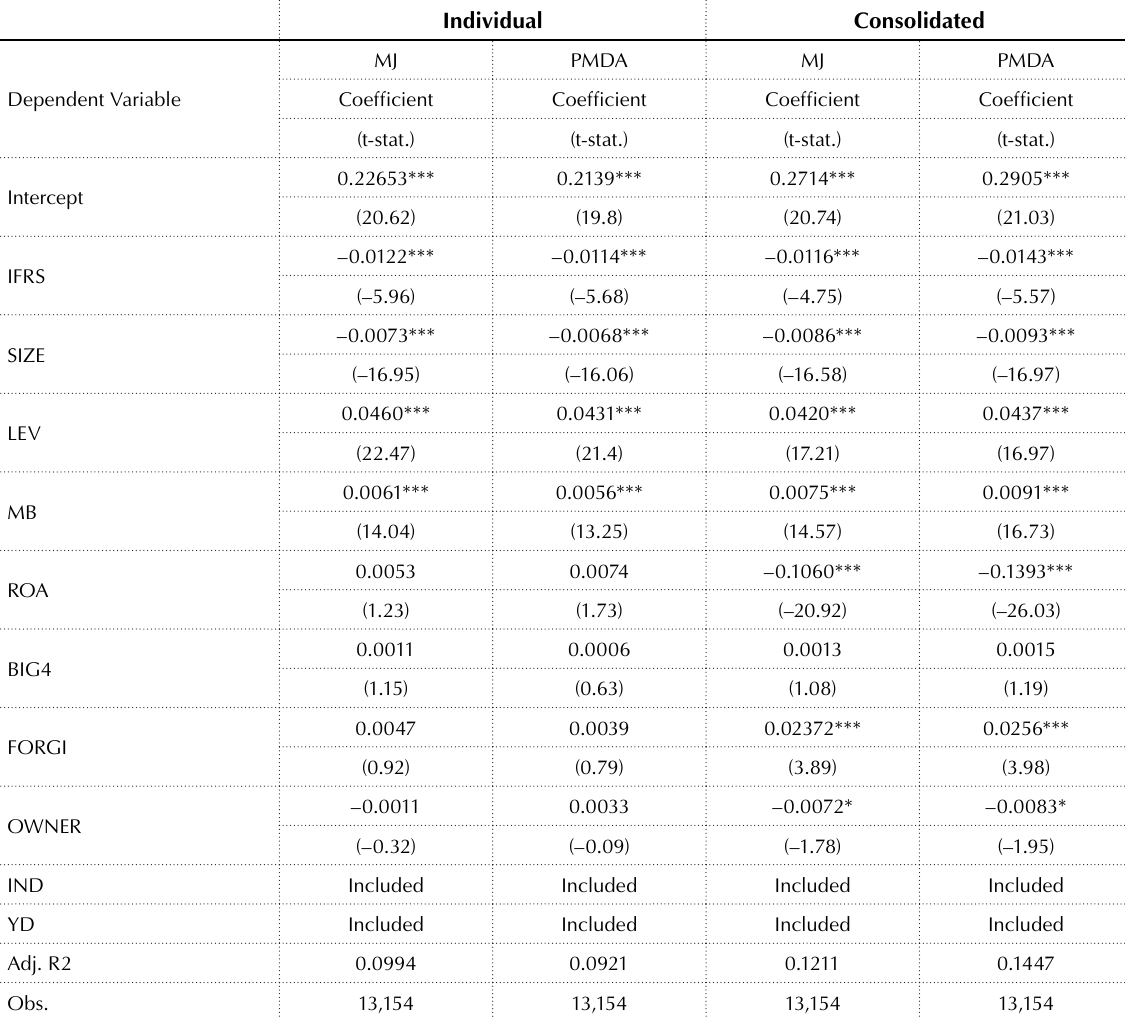
Table 3. Test results of hypothesis